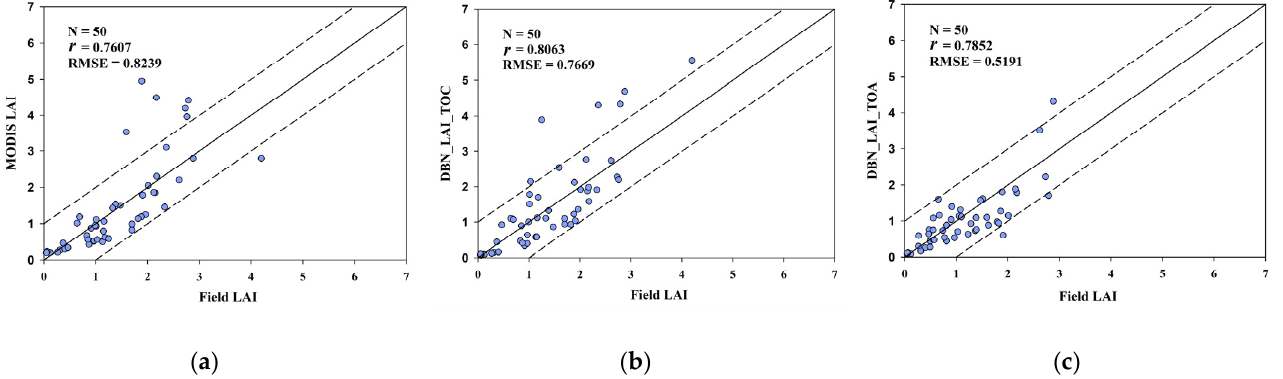
Figure 6. Scatterplot between the field-measured data and the ( a ) MODIS LAI, ( b ) DBN_LAI_TOC, and ( c ) DBN_LAI_TOA. The black solid line is the 1:1 line, and the red solid line is the regression line. The two intercepts of the dashed lines are ± 1.